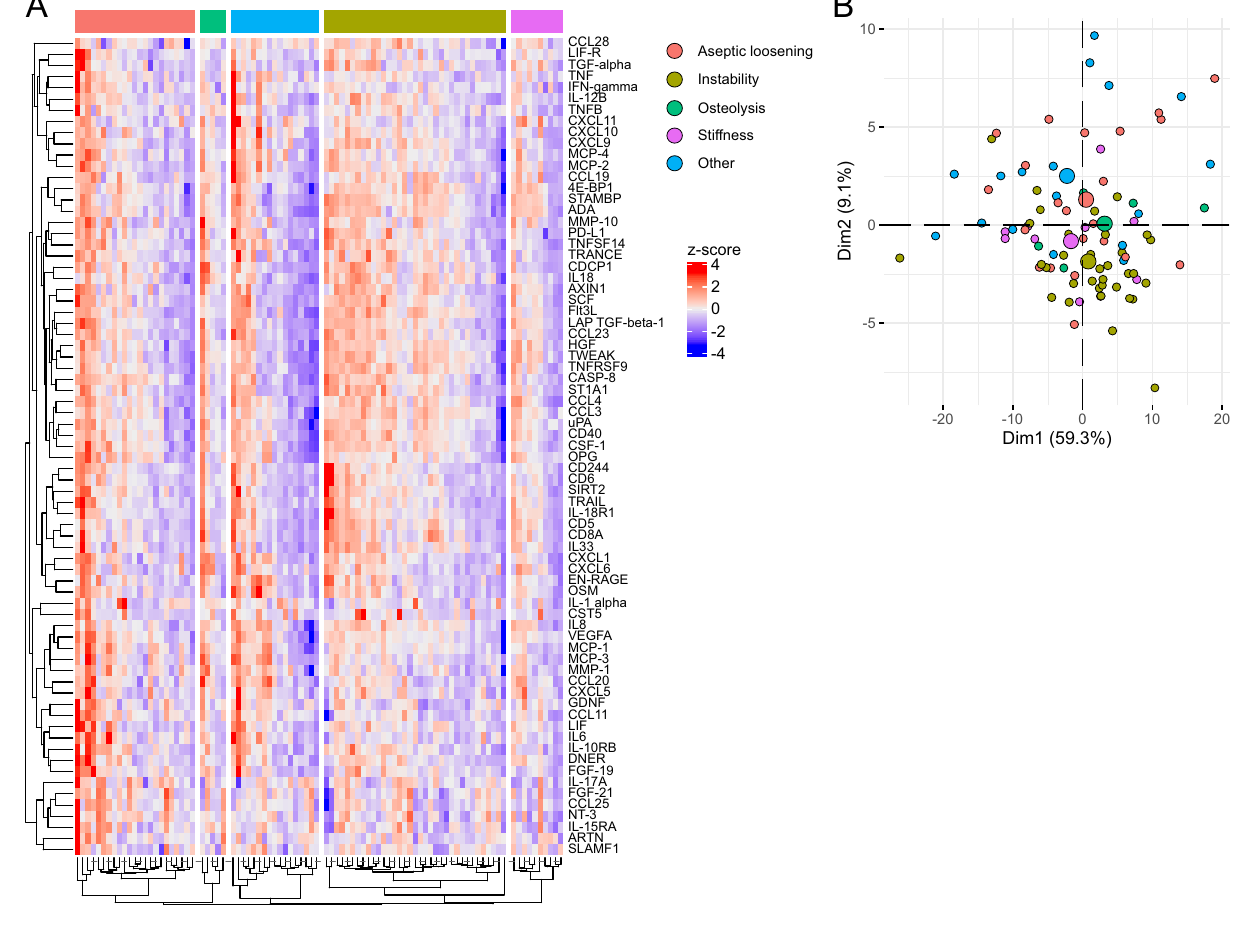
Figure 4. Proteomic profiling of non-infectious arthroplasty failure (NIAF) subtypes using the Olink Proteomics - Inflammation Panel. ( A ) Heatmap analysis of NIAF subset protein expression z-scores, including aseptic loosening, instability, osteolysis, stiffness, and other, with protein targets clustered. ( B ) Principal component analysis (PCA) showing grouping of NIAF based on Dim1 and Dim2. Larger points indicate geometric means of the sample population. Statistical significance was determined via Welch’s 2-sample t-test, with Benjamini–Hochberg multiple comparison adjustment. Data depict aseptic loosening (n = 23), instability (n = 35), osteolysis (n = 10), stiffness (n = 5), and other (n = 17) sonicate fluid